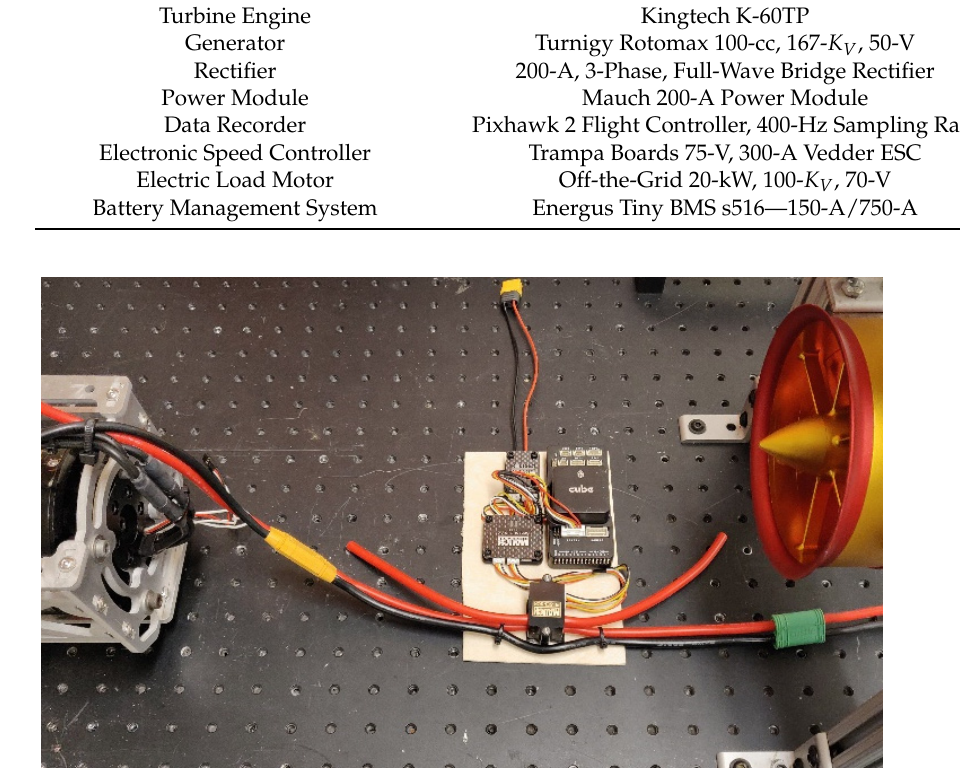
Figure 5. A photo of the Mauch Power Module used to measure voltage and current between the turboelectric system and the load (both lines of the power module were used during the testing for this paper).